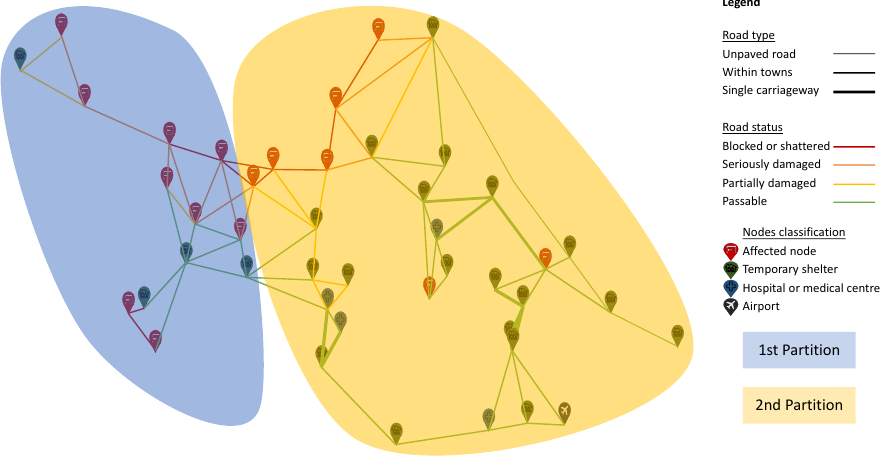
Figure 6. Splitting the network into two